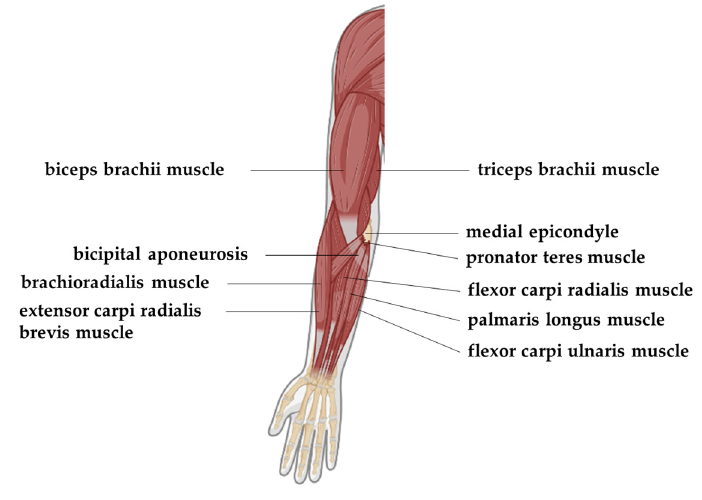
Figure 1. Anatomy of the human forearm (anterior view, superficial layer).